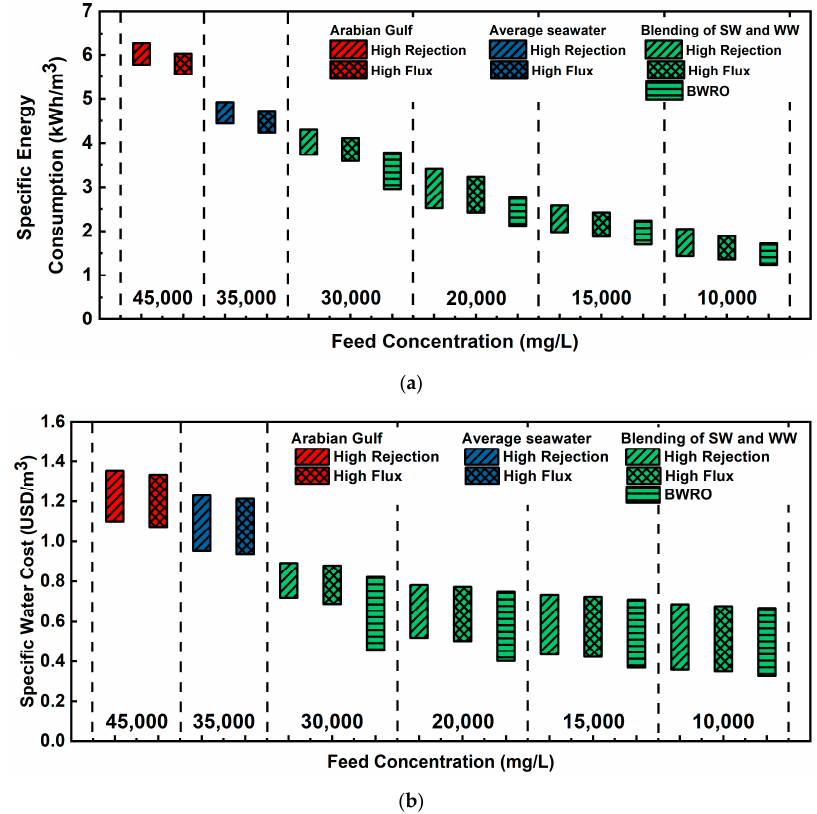
Figure 5. ( a ) Specific energy consumption (SEC) variation by feed concentration, recovery rate, and RO membrane types. ( b ) Water cost variation by feed concentration, recovery rate, and RO membrane